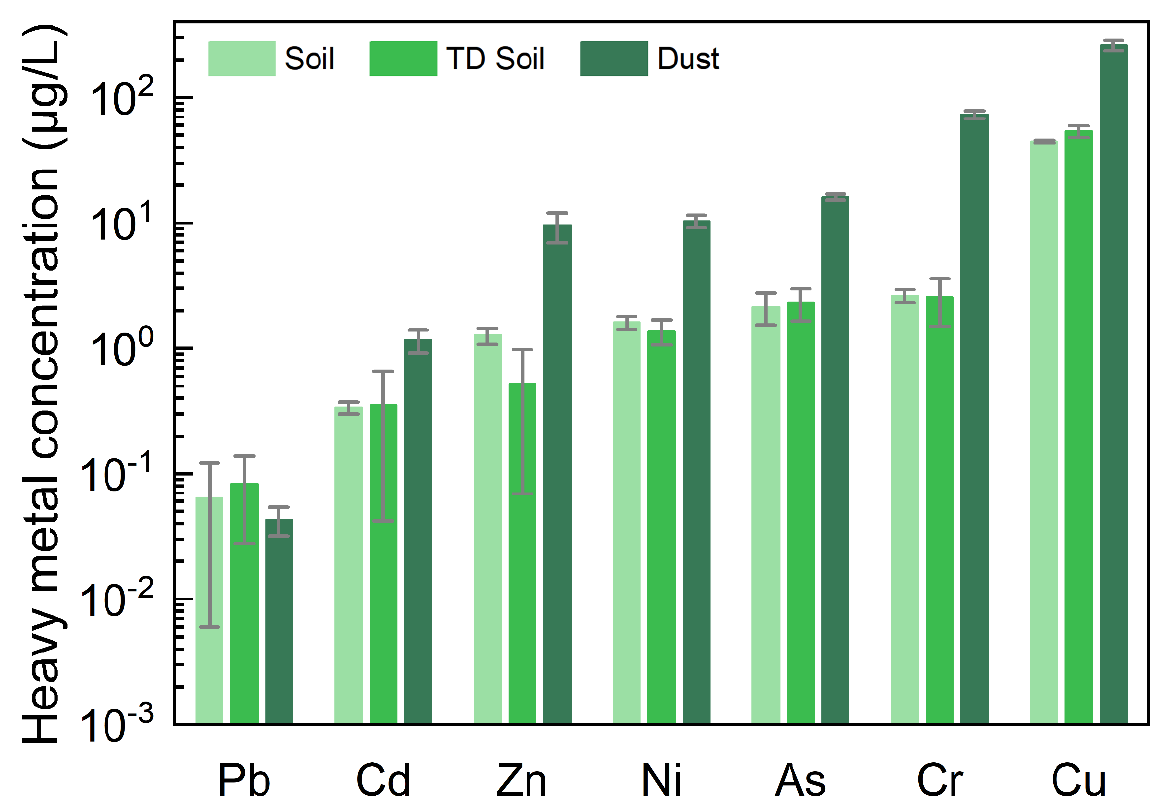
Figure 1. Leaching concentrations of HMs in one-step batch leaching tests ( n = 3). The content of Pb, Cd, Zn, Ni, As, Cr, and Cu in the samples. The leaching concentrations of HMs, from low to high, were in the following order: Pb, Cd, Zn, Ni, As, Cr, and Cu. Because the concentrations of Pb were near the detection limit, Pb is not included in the discussion of the leaching results in Section 3.1.1. In the dust samples, the leaching concentrations of Cd, Zn, Ni, As, Cr, and Cu were 1.17 μg/L, 9.50 μg/L, 10.35 μg/L, 16.11 μg/L, 73.18 μg/L, and 261.47 μg/L, respectively. The class III groundwater quality standard was used as a reference (Table S2).